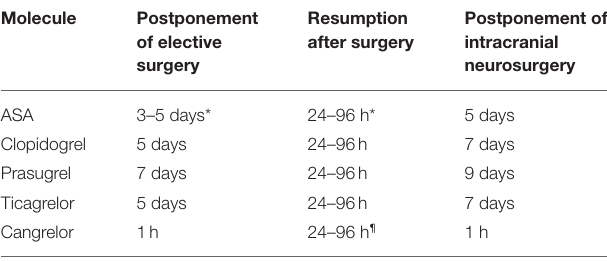
TABLE 3 | Perioperative management of antiplatelet drugs in case of elective non-cardiac surgery.